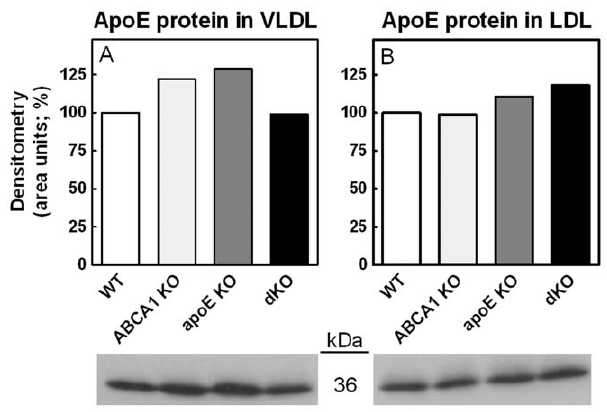
Figure 3. ApoE protein content in VLDL and LDL fractions from ABCA1 and/or apoE KO transplanted LDLr KO mice and their WT transplanted controls. Western blots showing apoE protein expression in VLDL (A) and LDL (B) isolated from ABCA1 KO and/or apoE KO transplanted LDLr KO animals and WT transplanted controls after feeding the HF/HC diet for 9 weeks. Samples were adjusted for cholesterol content. The density of the bands was determined using quantification software (Image J). n $ 5 samples per group (pooled). WT